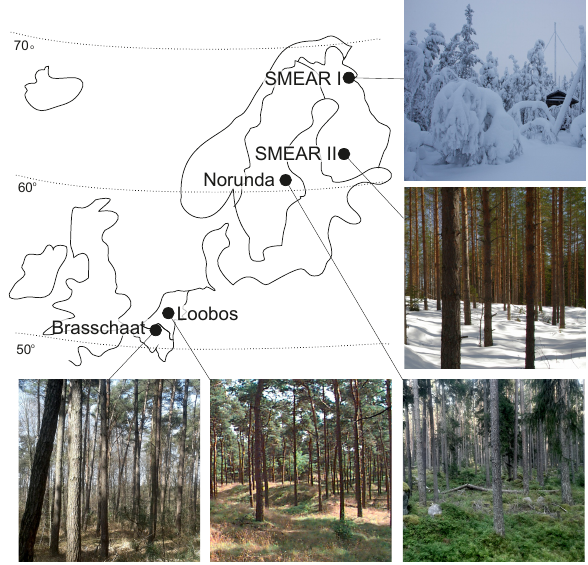
Figure 1. The location of the measuring stations in Europe and pho- tos of the stands. The photo of SMEAR I was taken in December; SMEAR II in early spring; and Norunda, Loobos and Brasschaat in